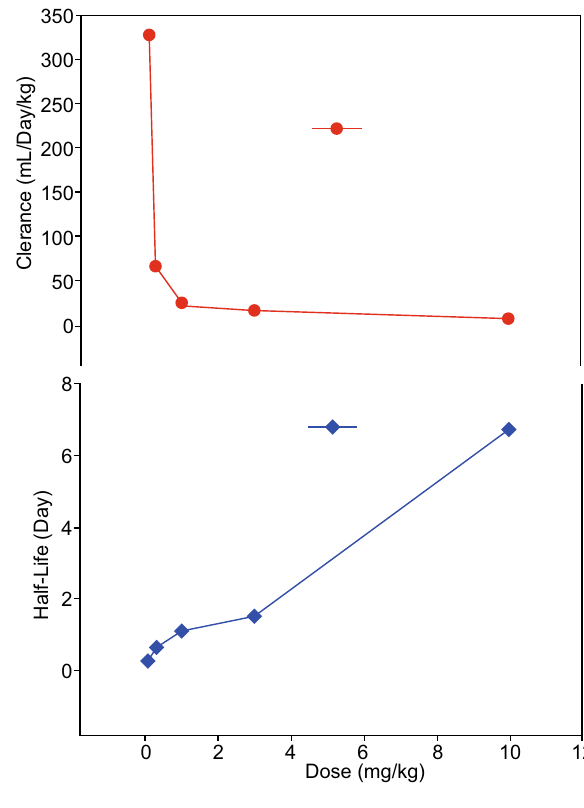
Figure 4. A typical TMDD graph exhibiting the rela- tionship between clearance or t 1/2 and mAb dose. Anti- α v mAb was infused to cancer patients; clearance or terminal half-life (t 1/2 ) was plotted against dose (0.1, 0.3, 1, 3, and 10 mg/kg). Adapted from Mullamitha et al., Clin Cancer